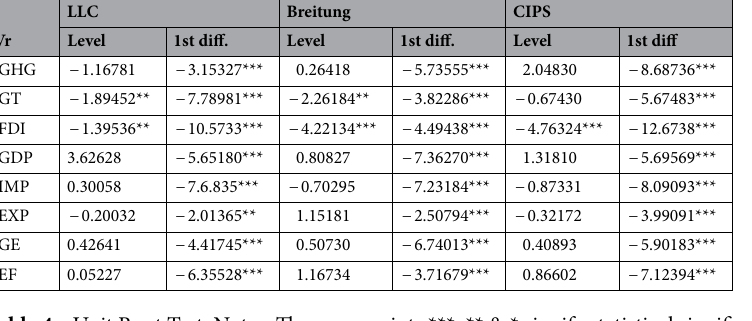
Table 4. Unit Root Test. Notes: The superscripts ***, ** & * signify statistical significant at the 1%, 5% and 10%